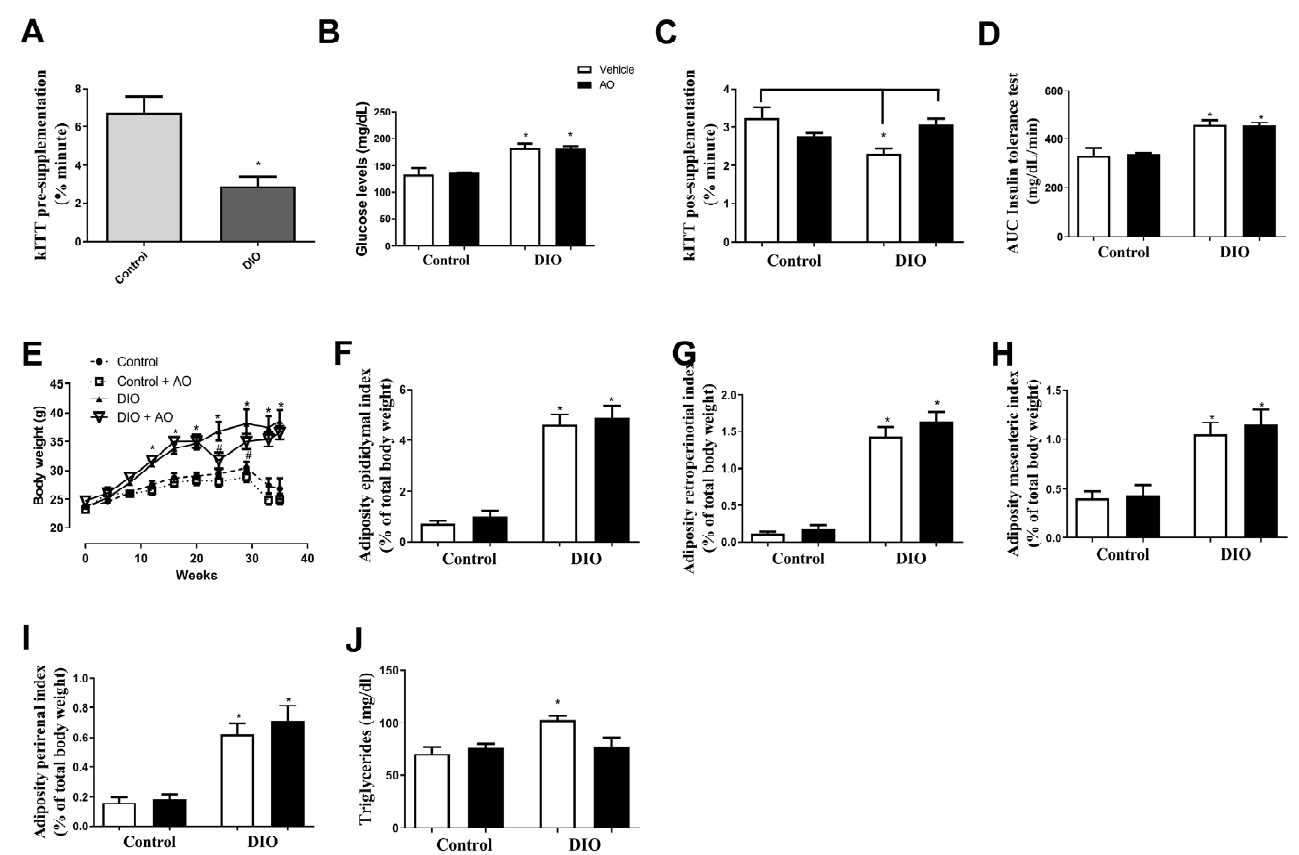
Figure 2. Effects of avocado oil (AO) supplementation on insulin sensitivity, fat pad index, and serum triglyceride and lipoprotein levels in mice with diet-induced obesity (DIO). ( A ) Rate of glucose decay (k ITT ) pre-supplementation after insulin intraperitoneal injection (* DIO < control, p < 0.05). ( B ) Fasting blood glucose levels (* DIO and DIO + AO > control and control + AO, p < 0.05). ( C ) Rate of glucose decay (k ITT ) after insulin intraperitoneal injection (* DIO < control and DIO + AO, p < 0.05). ( D ) Area under the curve (AUC) of the insulin tolerance tests (* DIO and DIO + AO > control and control + AO, p < 0.05) ( E ) Body weight (* DIO and DIO + AO > control and control + AO; # DIO + AO < DIO,